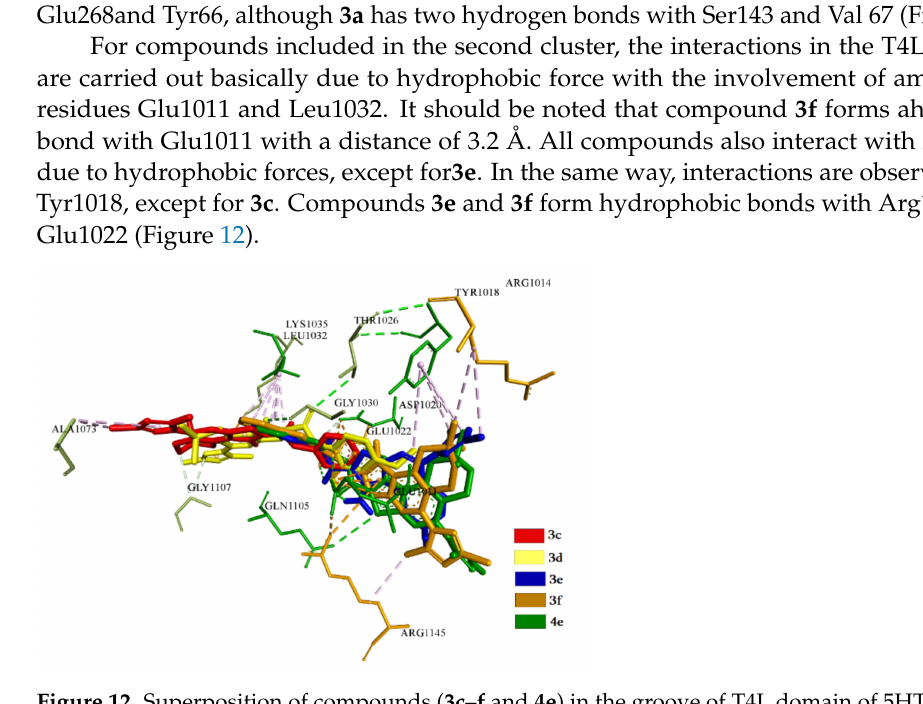
Figure 12. Superposition of compounds ( 3c – f and 4e ) in the groove of T4L domain of